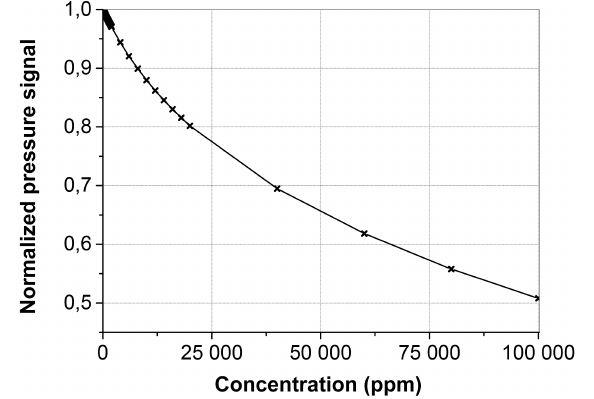
Figure 6. Simulated sensor response for CO 2 concentrations up to 100000ppm in the measurement path. Parameters are chosen as listed in Table